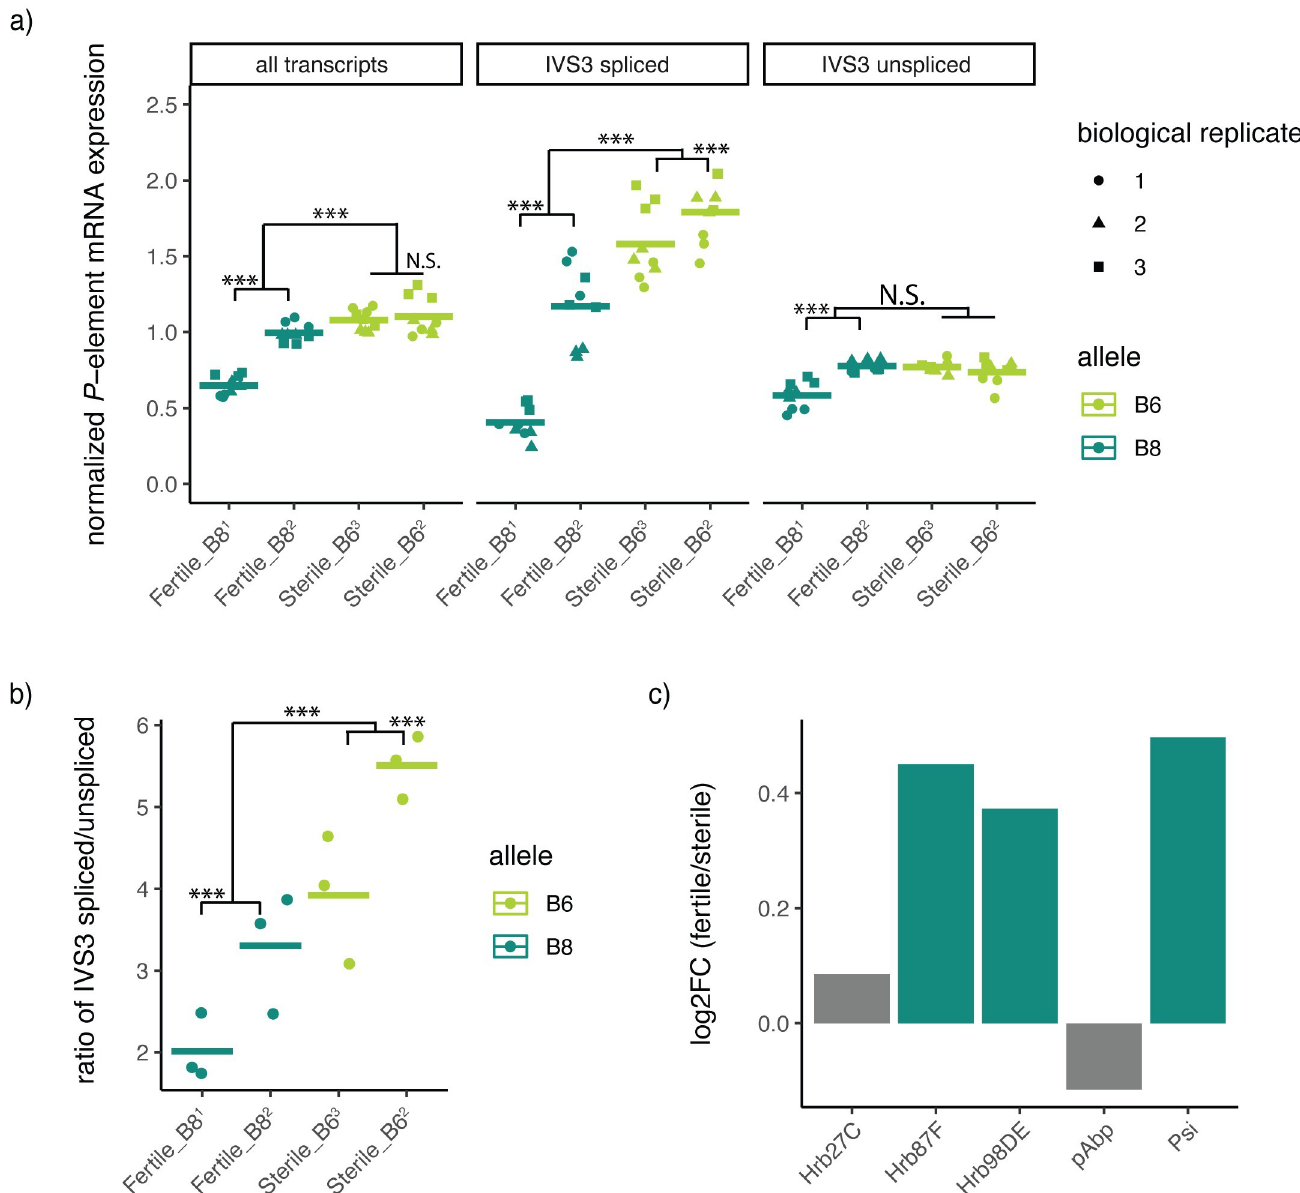
Fig 4. Decreased expression of P-transposase in fertile genotypes. A) Differential expression of P -elementtranscripts between fertile and sterile genotypes. Three separate qPCRs were performed, which detect all transcript isoforms, as well as IVS3 spliced and unspliced isoforms. qPCRs are normalized to rpl32. B) Ratios of IVS3 spliced to unspliced isoforms. C) Differential expression of splicing factors between sterile and fertile genotypes based on RNA-seq data. Dark green bars indicate factors that are significantly upregulated in fertile genetic backgrounds. Significant differences in qPCR data are based on linear modelsto detect differences between sterile and fertile genotypes, or Tukey-HSDcomparisons to detect differences between genotypescontaining the same allele. ��� denotes P <